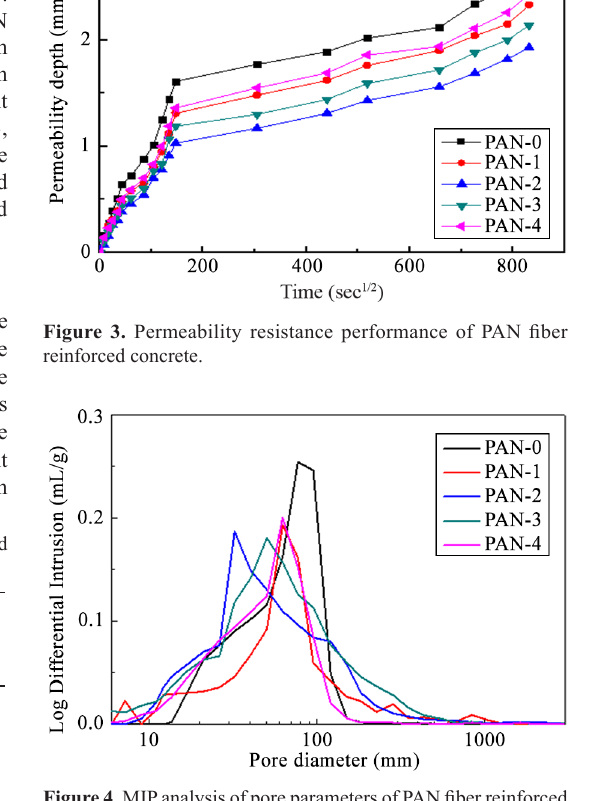
Table 6. Pore parameter of PAN fiber reinforced concrete.